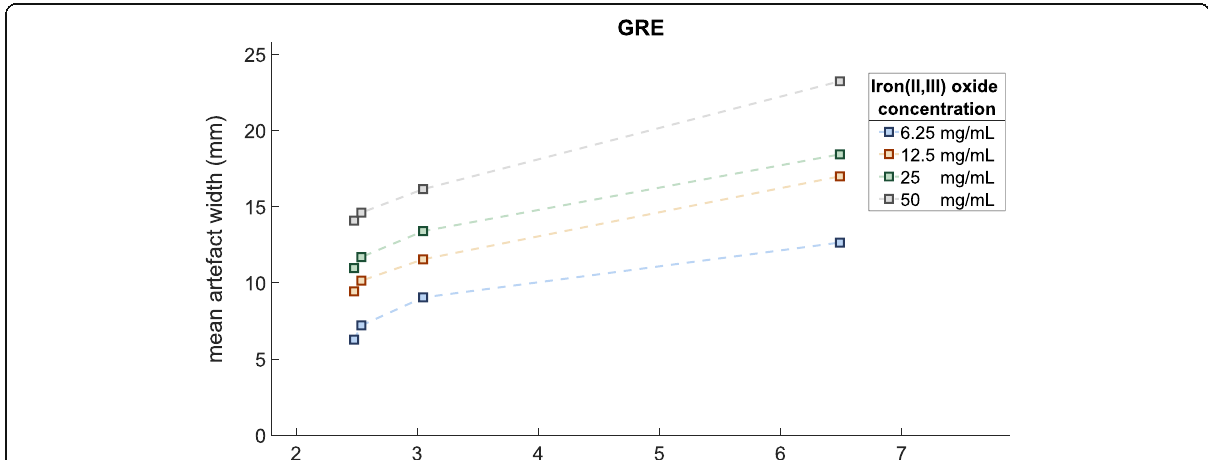
Fig. 4 Graph displaying the cumulative effect of adjusting echo time and iron(II,III)oxide concentrations on mean artifact width for gradient echo